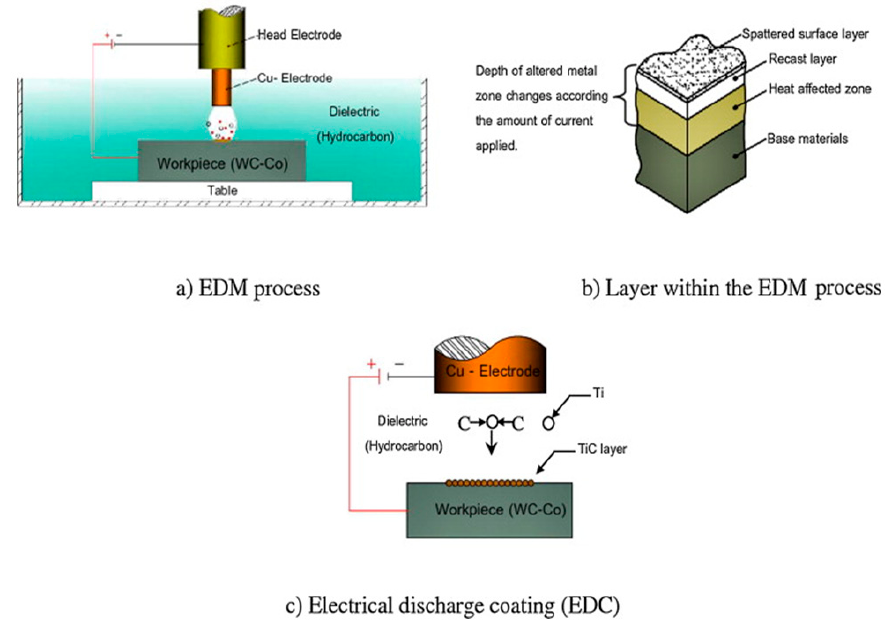
Figure 18. ( a ) EDM process and ( b ) layer within EDM and ( c ) EDC [114].